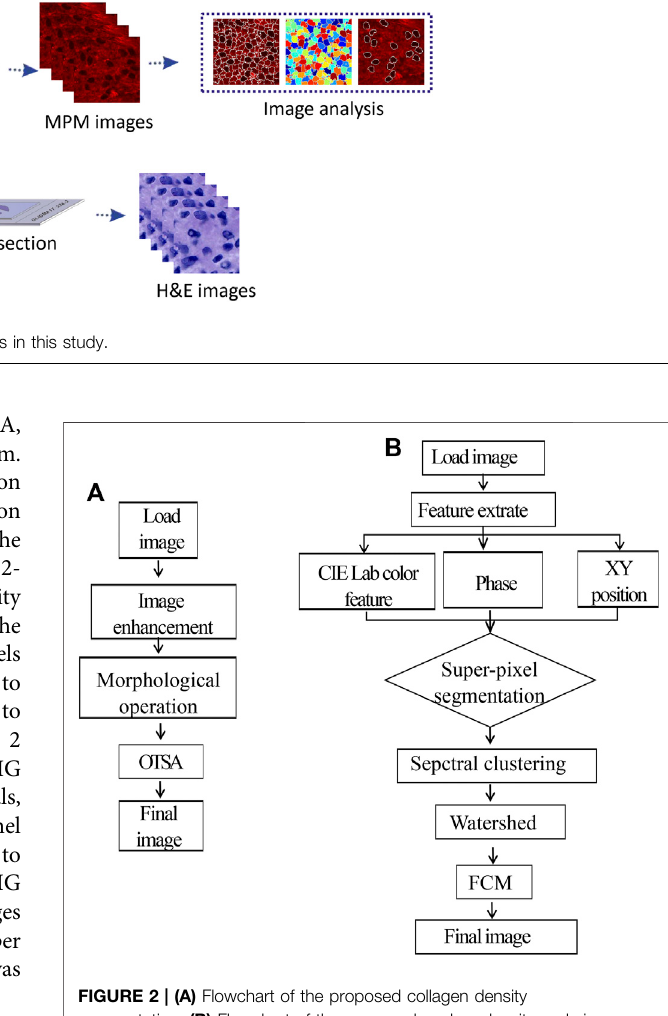
FIGURE 2 | (A) Flowchart of the proposed collagen density segmentation. (B) Flowchart of the proposed nuclear density and size